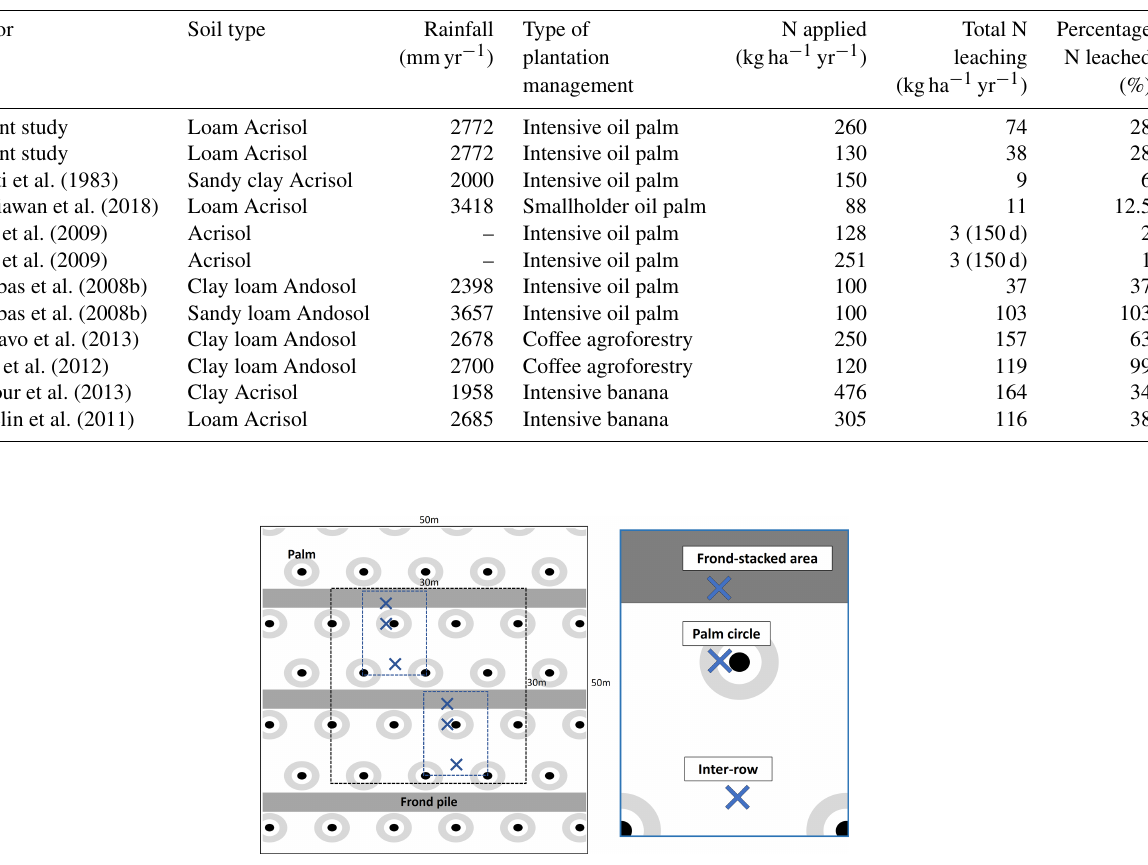
Table A3. Literature comparison of annual N fertilization and total N leaching losses across tropical plantations.